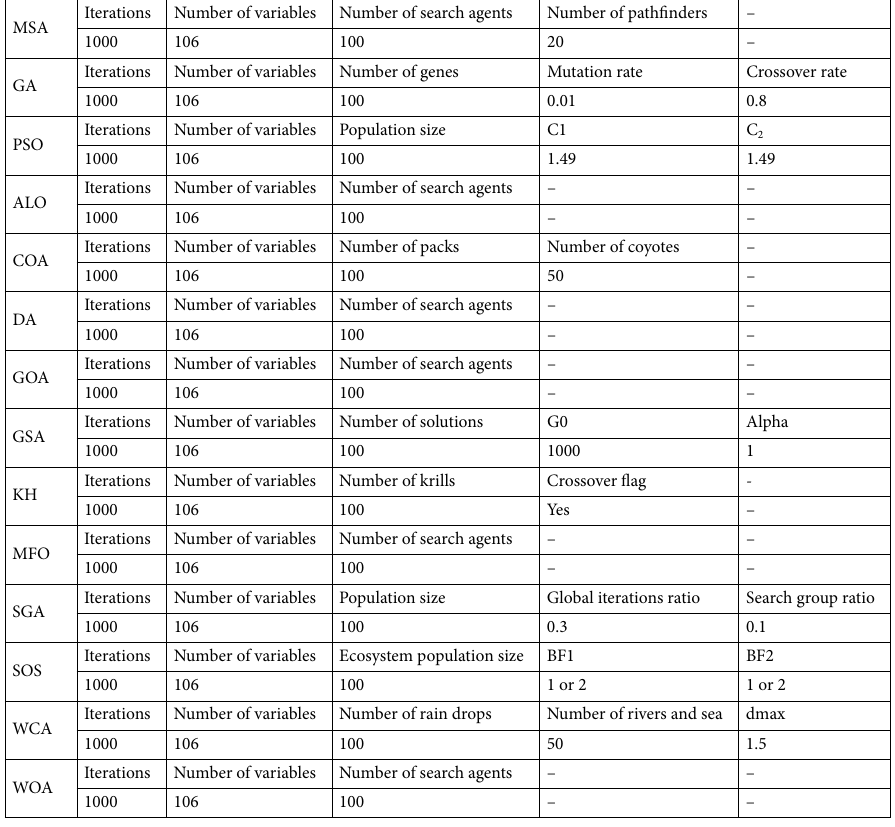
Table 3. Values of algorithms parameters for Karun-4 hydropower reservoir